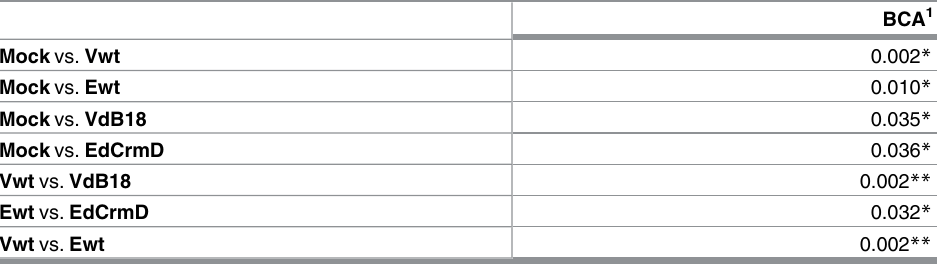
Table 1. Differencesbetween community compositions. Results represent p-values of Monte Carlo per- mutation tests assessing the significanceof experimental groups after controllingfor possiblebatch